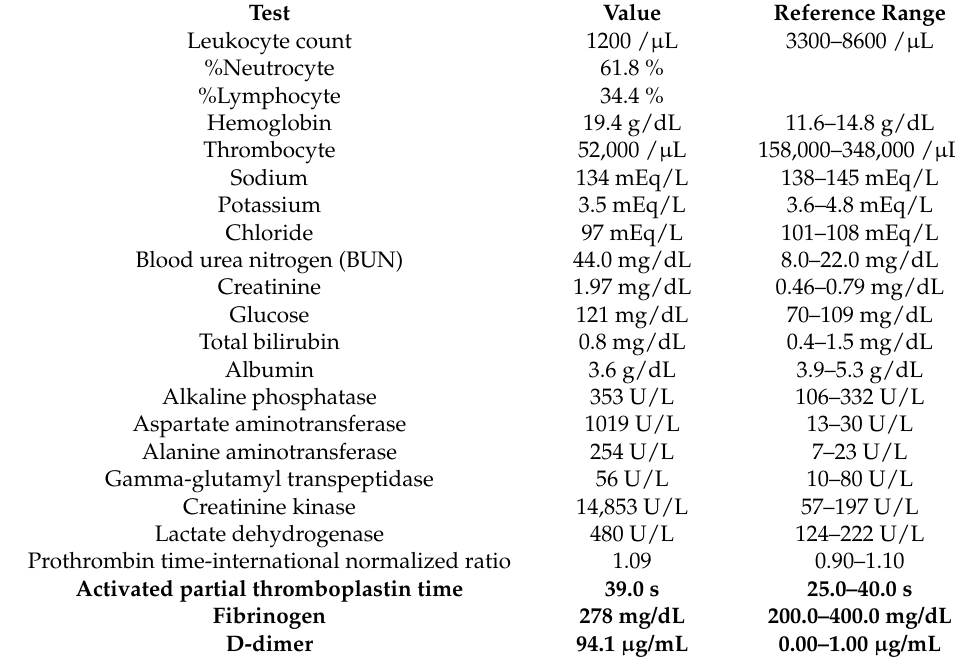
Table 1. Blood test result on admission (Day